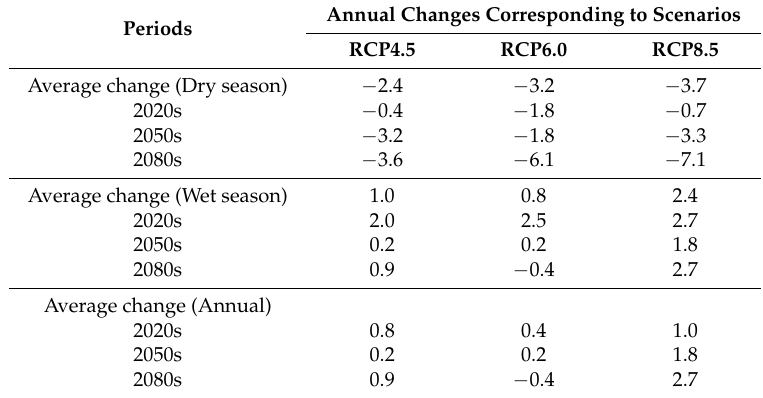
Table 4. Annual changes in future rainfall under the RCP45, 60 and 85 scenarios.